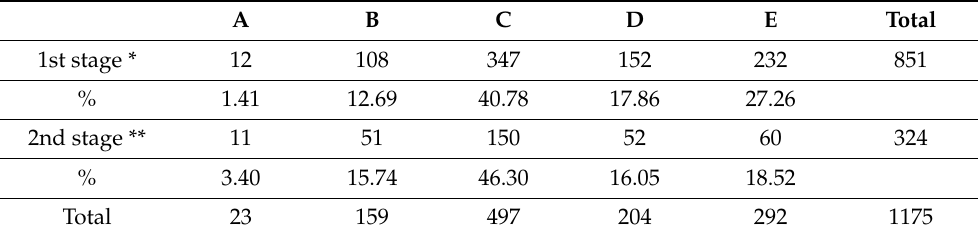
Table 3. Pupils’ answers to the question “ Where do you do sports most often?” before and after the situation caused by COVID-19. A B C D E Total 1st stage * 12 108 347 152 232 851